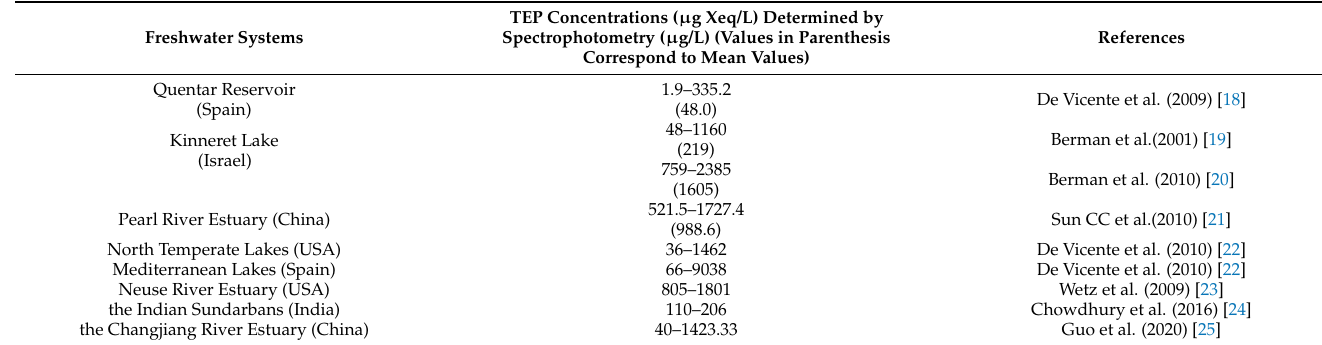
Table 1. TEP concentrations in freshwaters based on spectrophotometry.